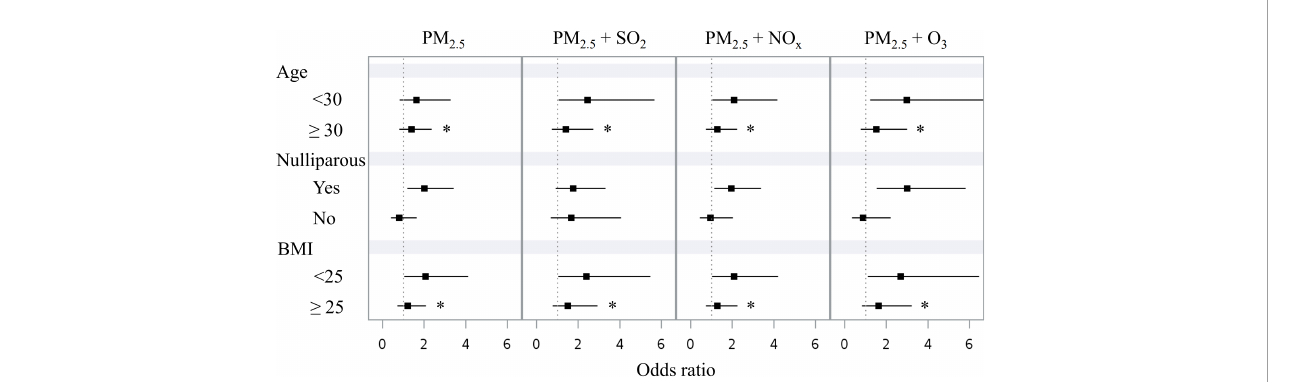
FIGURE 2 Forest plot displaying the associations between mean concentrations of air pollutants in the second trimester and GDM in different subgroups: age (<30 vs. ≥ 30 years), nulliparous (yes vs. no), and BMI (<25 vs. ≥ 25 kg/m 2 ). BMI, body mass index. GDM, gestational diabetes mellitus. PM 2.5 , particulate matter with an aerodynamic diameter less than 2.5 m m. SO 2 , sulfur dioxide. NO x , nitrogen oxides. O 3 , ozone. *p interaction